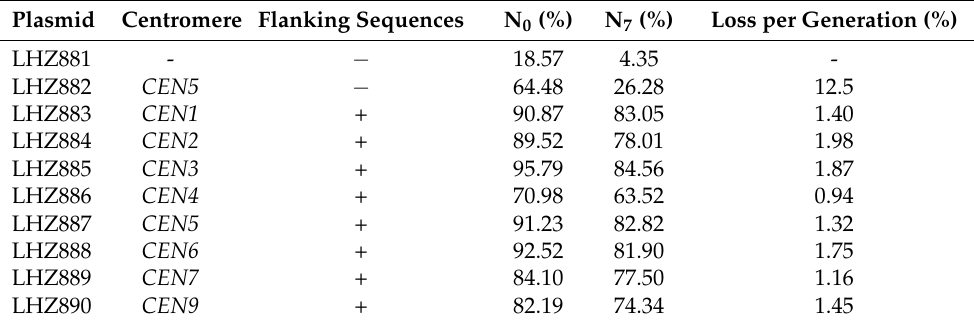
Table 1. The mitotic stability of plasmid carrying centromere of K. marxianus . Plasmid Centromere Flanking